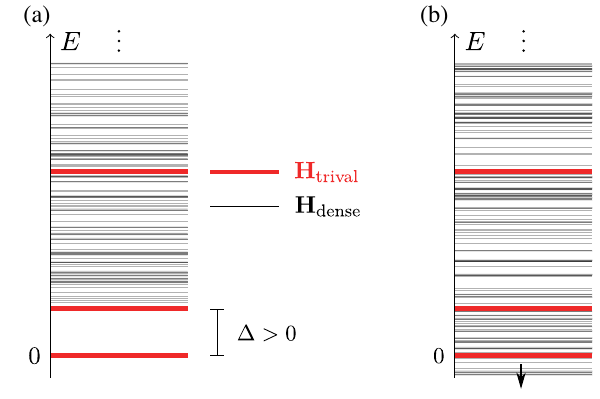
FIG. 1. Competing spectra of the gapless versus gapped phase for the Hamiltonian H ¼ ð H